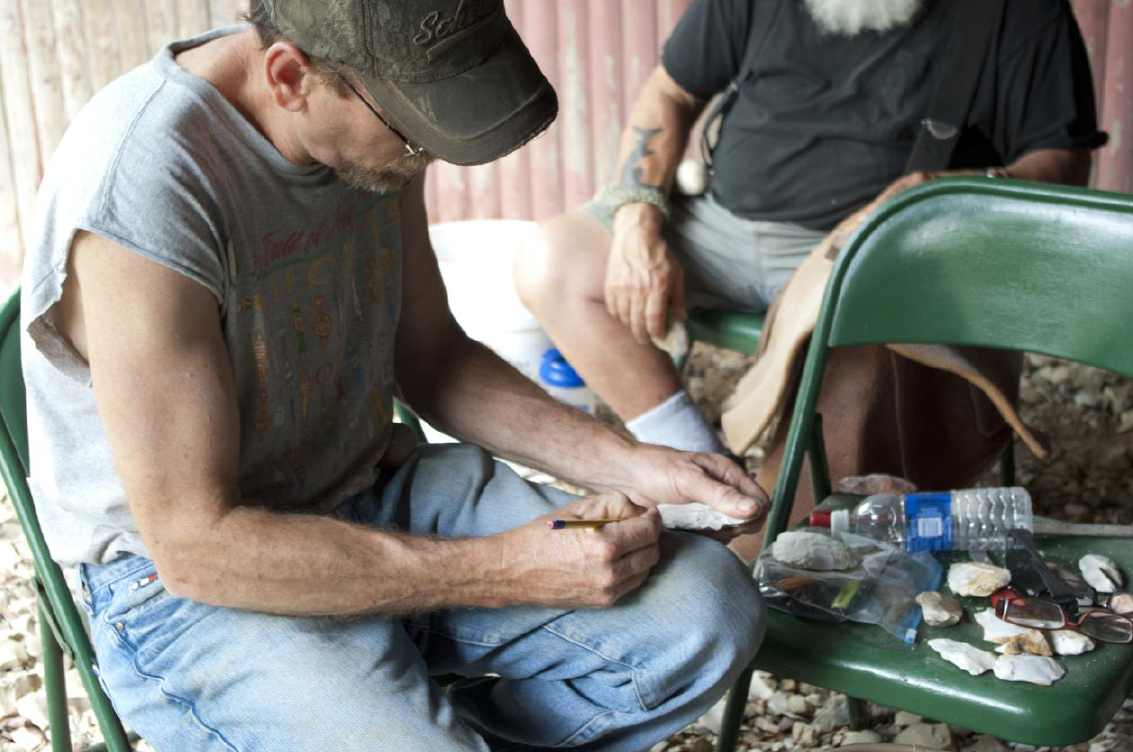
Figure 1. Expert traditional knapper, Tim Dillard, instructs students in where and how to remove flakes in the production of a biface. (Photo by Center for American Archeology.)